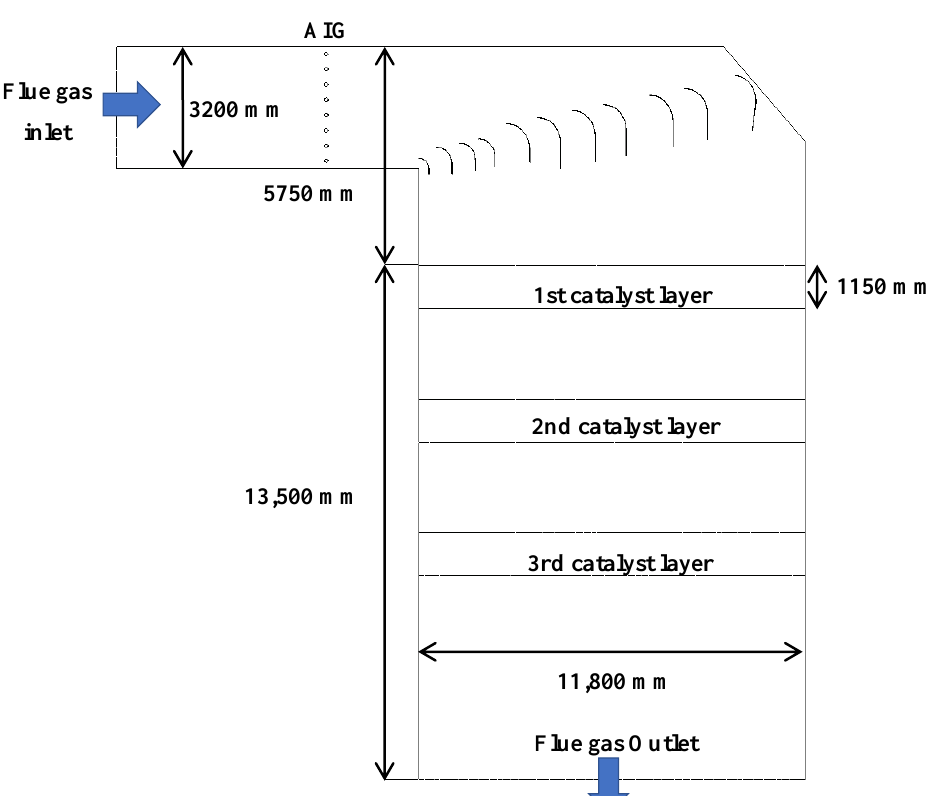
Figure 2. Set up of DeNO x facility in Samcheonpo thermal power plant.